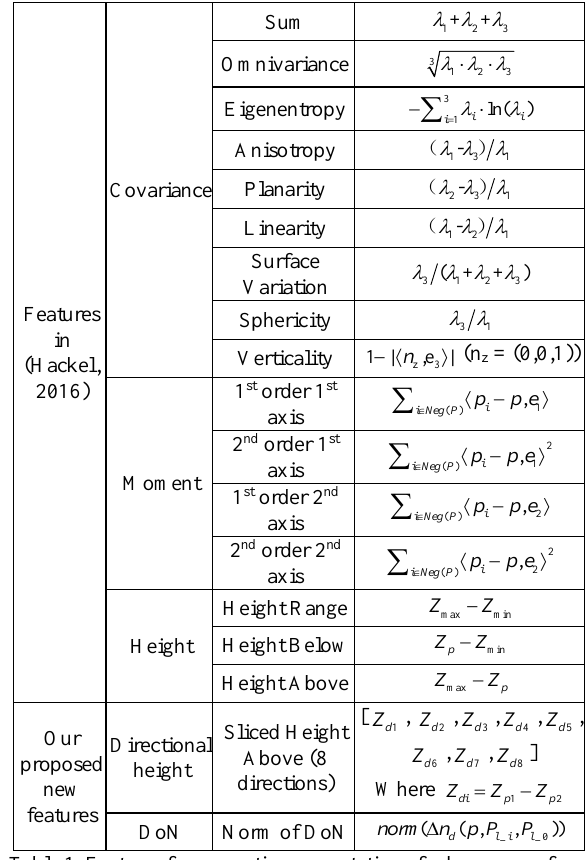
Table 1. Features for semantic segmentation of urban scenes from LiDAR point